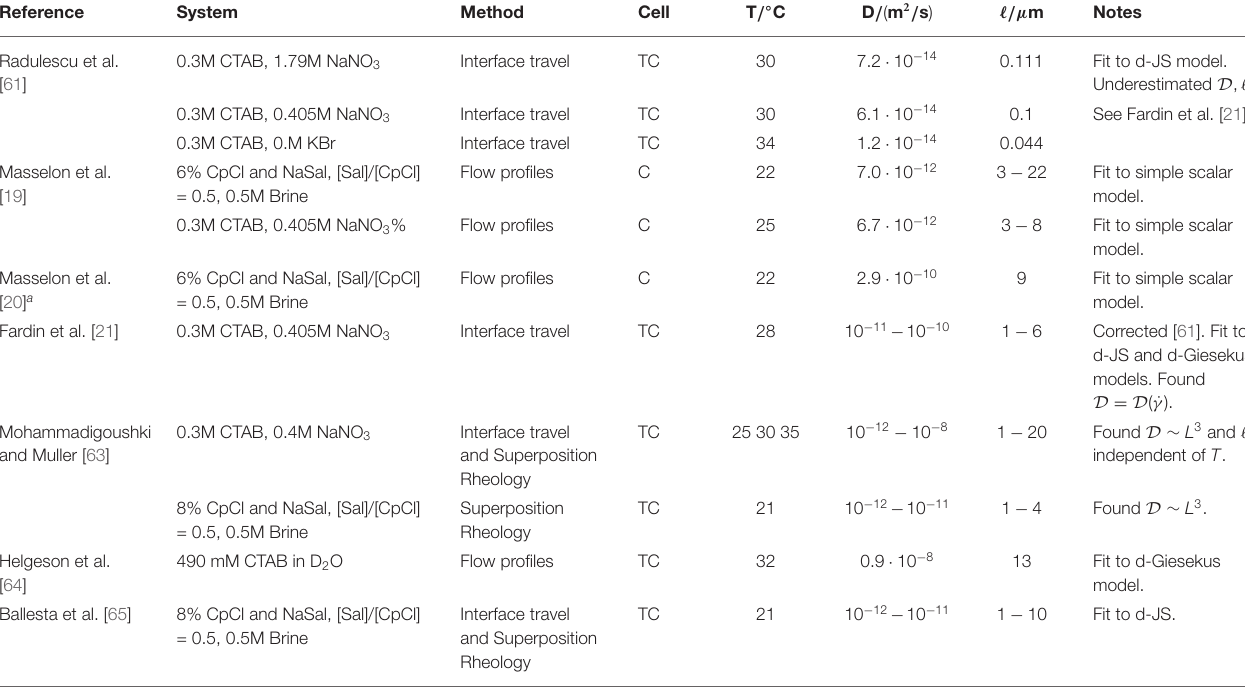
TABLE 2 | Summary of measurements of the interface length ℓ , based on different techniques in channels flow (C) or Taylor Couette flow (TC) with a gap size L .